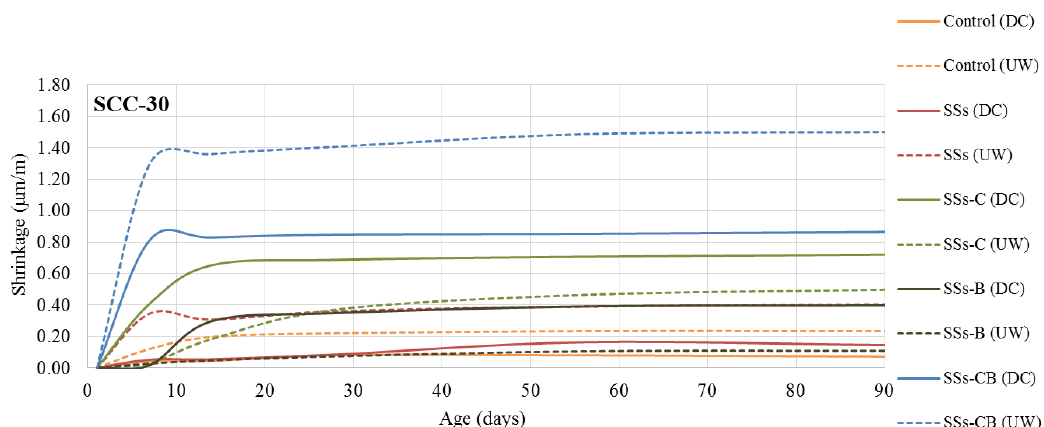
Figure 6. Shrinkage of the SCC-30 as a function of age in days. (UW) Underwater curing condition, (DC) Dry Chamber curing conditions.